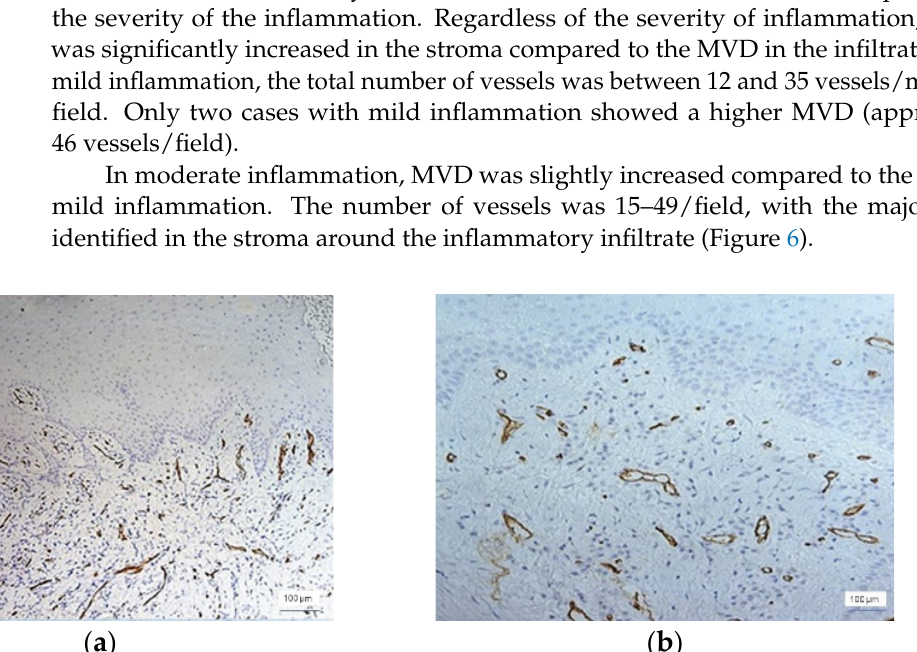
Figure 5. Severe inflammation, intussusception (arrow), intraluminal bridges dividing the blood vessel, anti-CD34 immunohistochemical staining, and DAB chromogen, × 200 magnification.